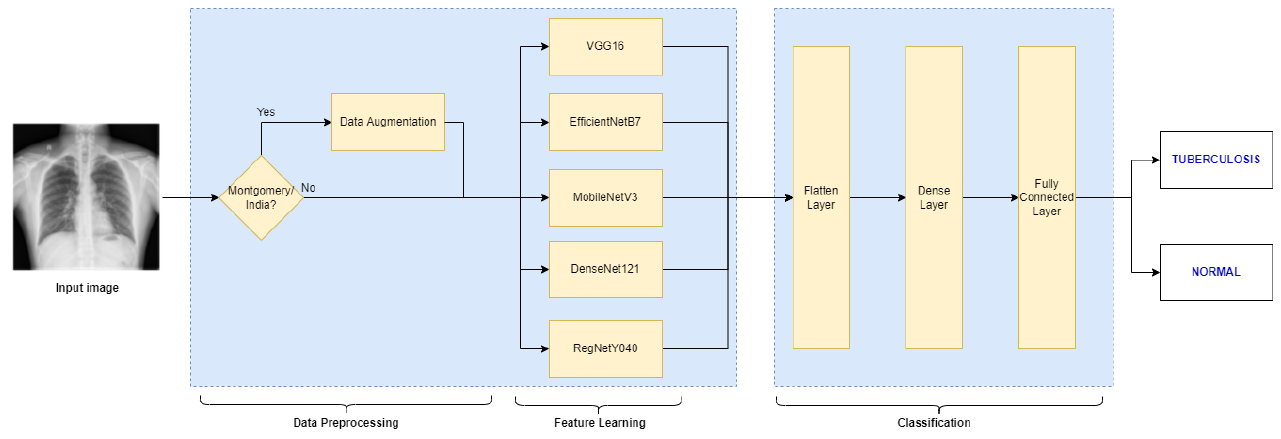
Figure 3. End-to-end approach of Chest X-ray classification